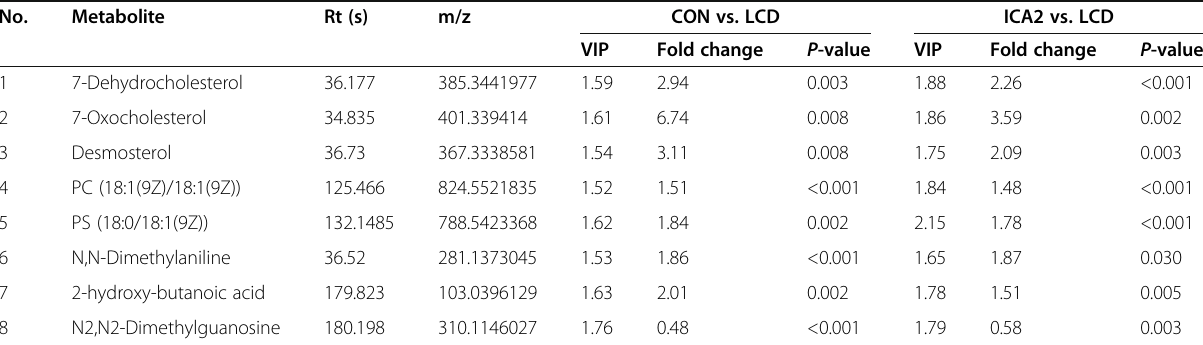
Table 1 ICA-induced 8 shared differential